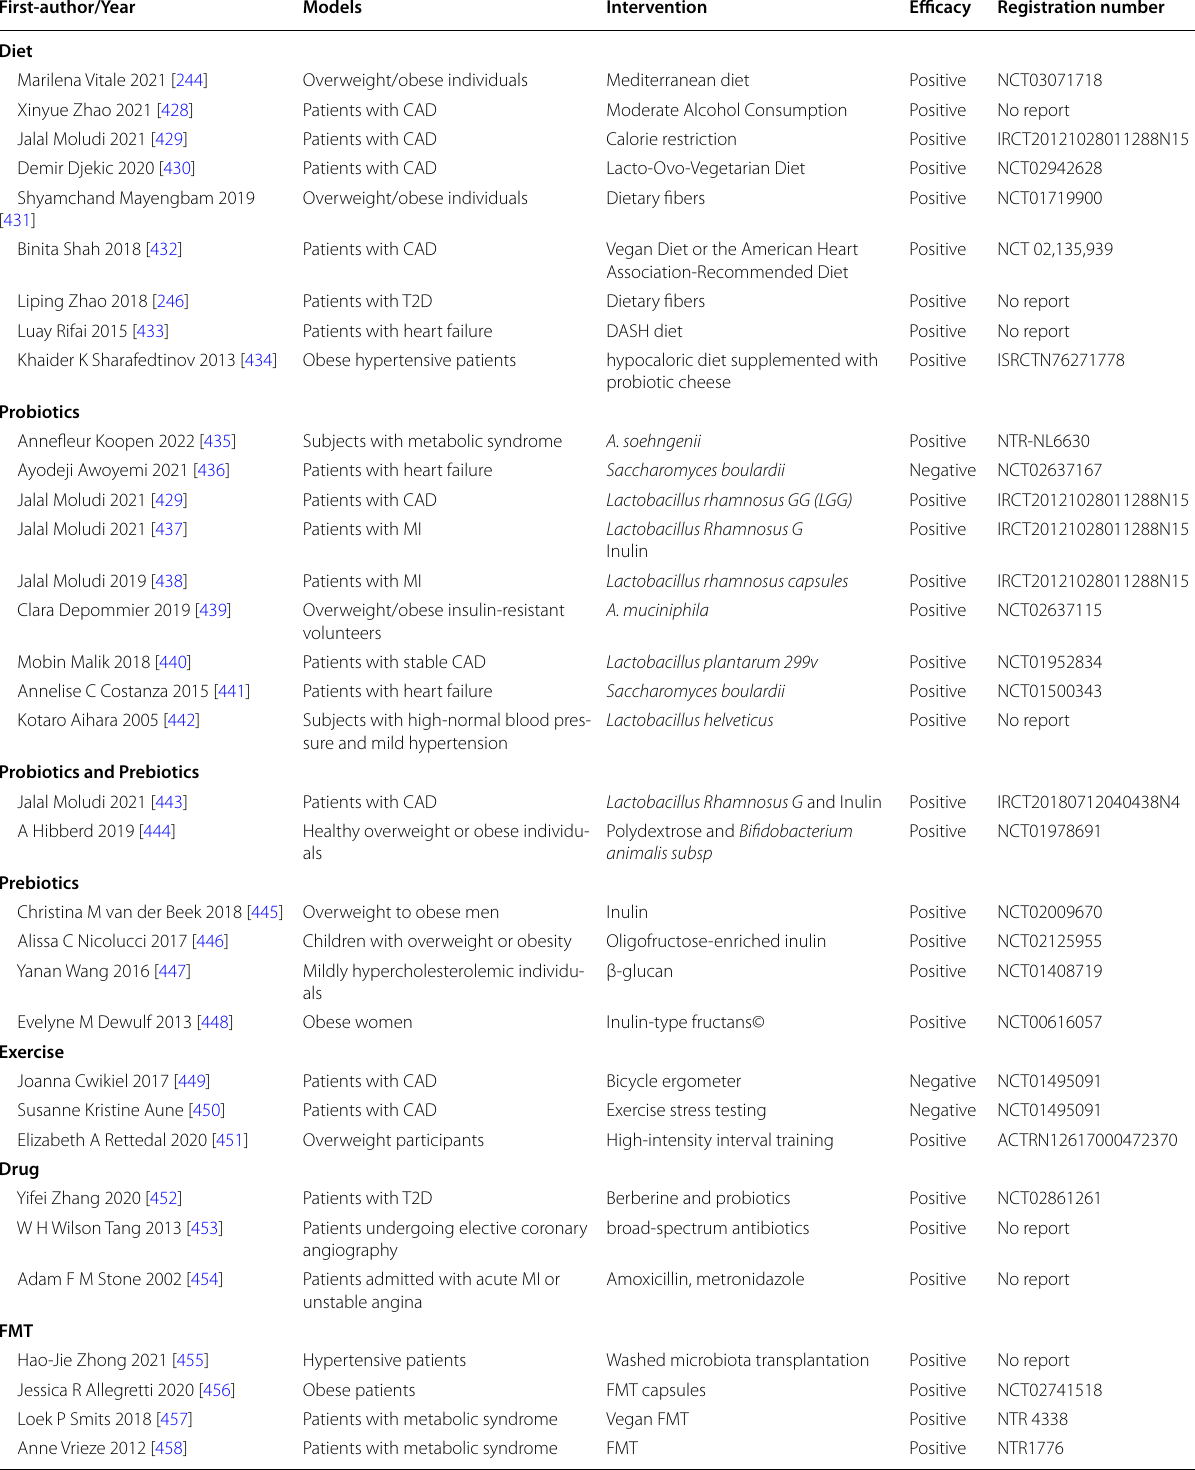
Abbreviation : CAD Coronary artery disease, MI Myocardial infarction, T2D type 2